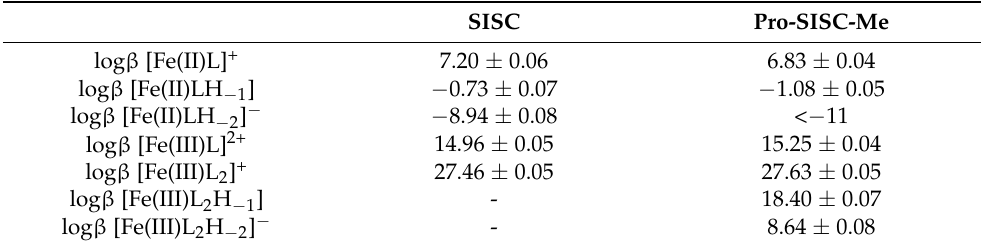
Table 3. Overall stability constants ( β ) of the Fe(II) and Fe(III) complexes formed with SISC and Pro-SISC-Me determined by pH-potentiometry in 30% ( v / v ) DMSO/H 2 O. HL is the neutral form of the ligands. ( T = 25 ◦ C, I = 0.10 M (KCl)).